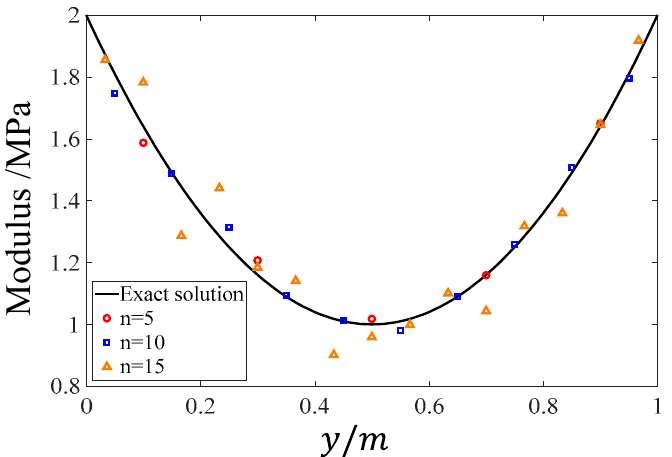
Figure 13. Converged 𝐸